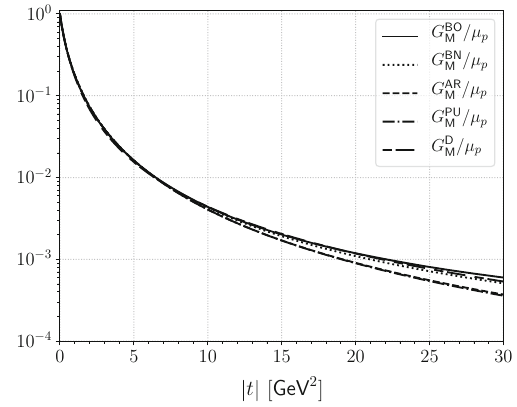
Fig. 14 Proton magnetic form factors G M ( t )/μ p having very similar t -dependences